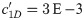
Optimal solutions compared to empirical data for four test cases.Left column shows an outline of the dog breed in question, with the approximate points used as morphological measurements. Middle column shows that gait diagrams for the empirical (grey) and optimal solutions (light blue) have substantial overlap (dark blue). Right two columns demonstrate that empirical ground reaction forces (GRF, black lines) qualitatively match optimization results. The optimization GRF from left (solid blue line) and right limbs (dashed red line) are very similar, reflecting the symmetrical solutions that are discovered. GRFs from double support are shown as grey lines (solid for empirical, dotted for simulation). At slow speeds (A-B), the simulation discovers a singlefoot walking gait, while at an intermediate speeds (C-D) it discovers trotting, matching natural gait choice in dogs. All optimizations use c1D′=3E-3. Contours adapted with modification from (A) [55], (B) [56], and (C-D) [57]. Empirical data and morphological measurements from [41, 45] (A), [37] (B), [42, 44] (C) and [44, 48] (D). For left column, circles show shoulder and hip positions, with relative size indicating the relative mass carried at these points. “x” marker indicates centre of mass position. For middle column, LH = Left Hindlimb, RH = Right Hind, LF = Left Fore, RF = Right Fore. Error bars in gait diagrams are described in the methods.